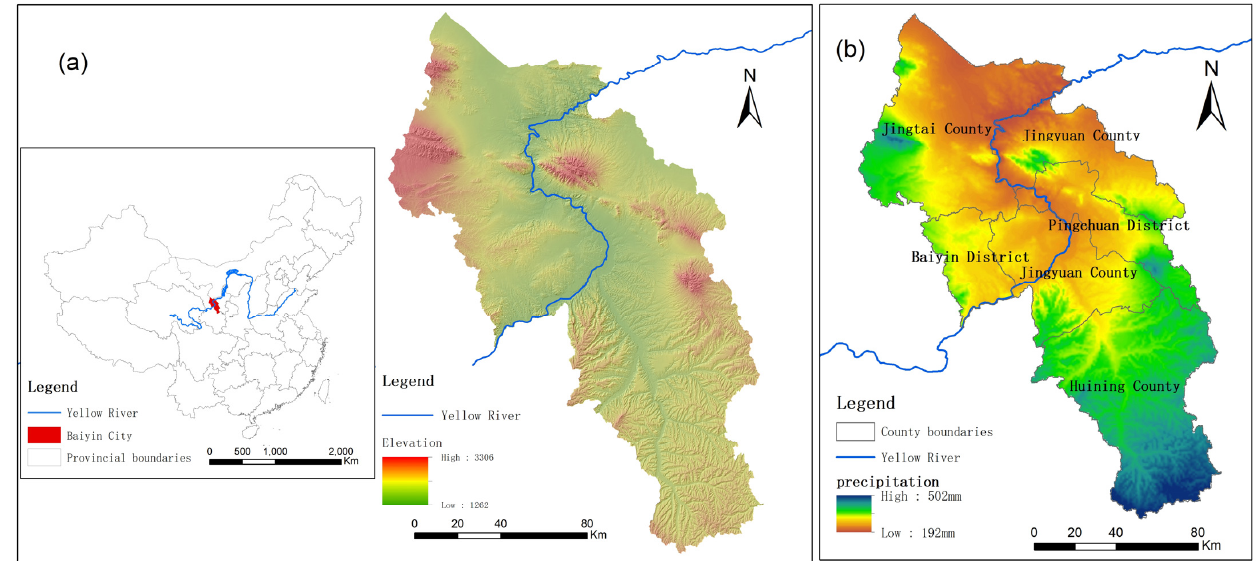
Figure 1. ( a ) Location of Baiyin City; ( b ) Average annual precipitation.